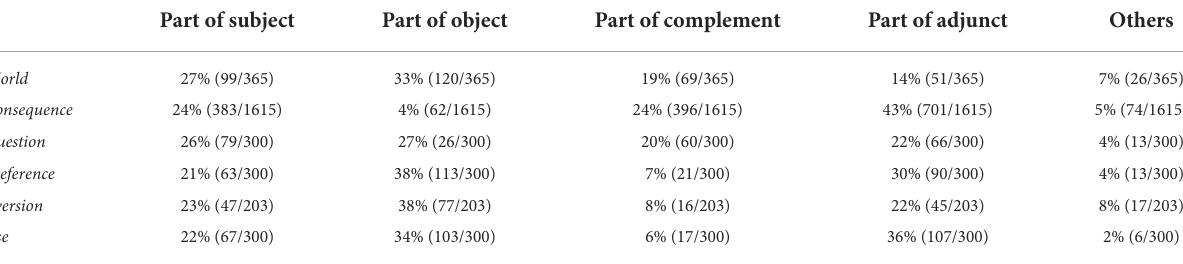
TABLE 10 A comparison of the grammatical distributions between world in a clause and that of five words discussed in Hoey (2005). Part of subject Part of object Part of complement Part of adjunct Others